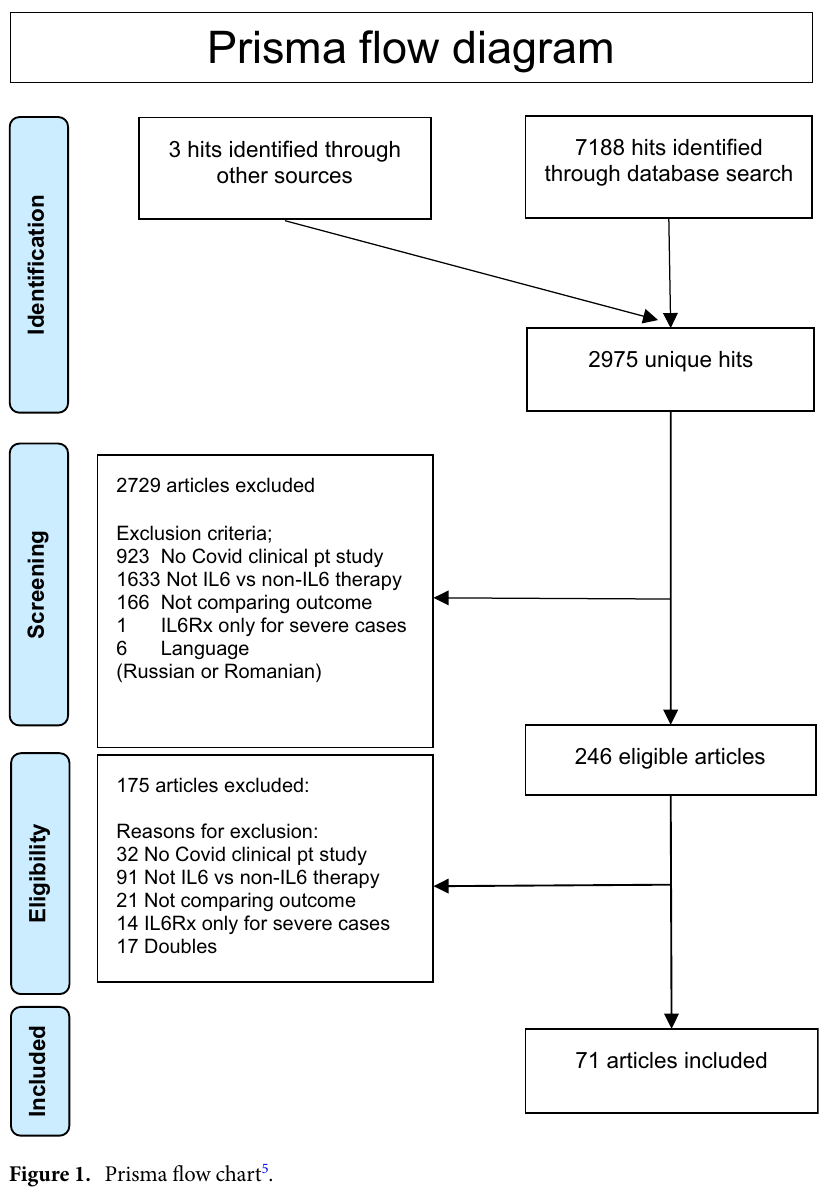
Figure 1. Prisma flow chart 5